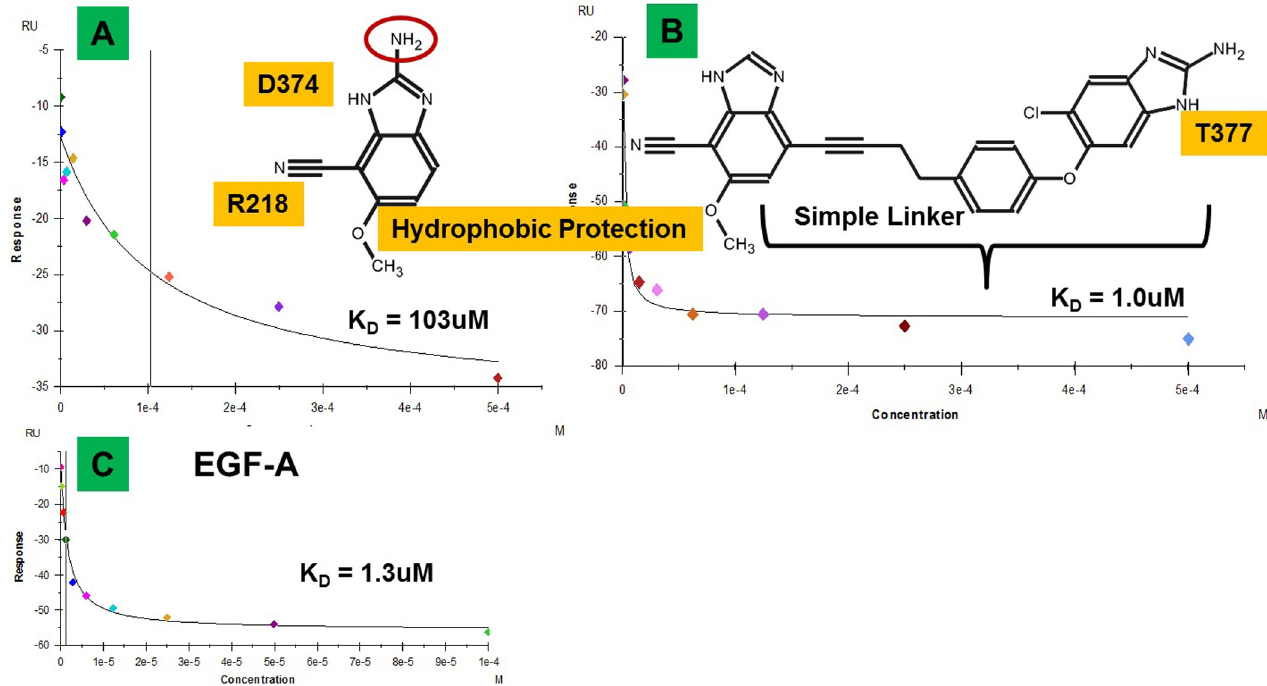
Fig 12. Surface plasmon resonance assay. The cyano-benzimidazole derivative (A) disrupts the PCSK9/LDLR PPI in SPR competition assays. There is no precedent, to our knowledge, for such a small fragment (MW ~ 200) breaking the PPI of a tertiary interface. The amine function circled in red is not relevant for the binding but was left on due to synthetic ease and because SACP indicates that there is free space in this location. The methoxy-ether group was added as hydrophobic protection for the polar interaction at R218 with the cyano group. A simple linker designed to not clash with PCSK9 was added to present the benzimidazole proton at T377 backbone to form the second interaction, resulting in a compound (B) that breaks the PPI with the same potency as the EGFa (C) protein domain of LDLR.